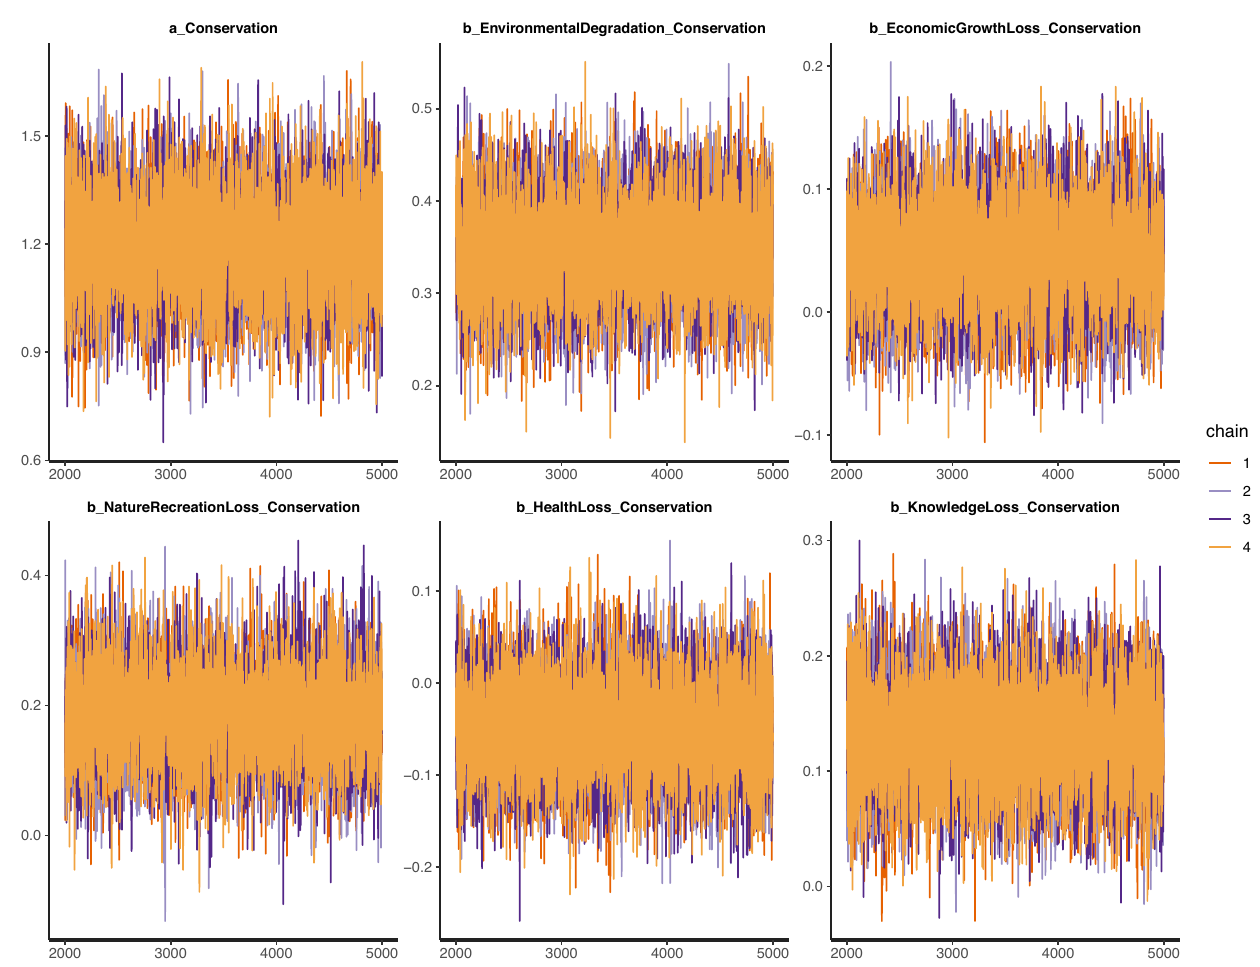
Fig. 3 Model 1 ’ s trace plots with priors as norm (1,0.5). The Markov chains are deemed well-convergent if the chains are good-mixing and stationary around an